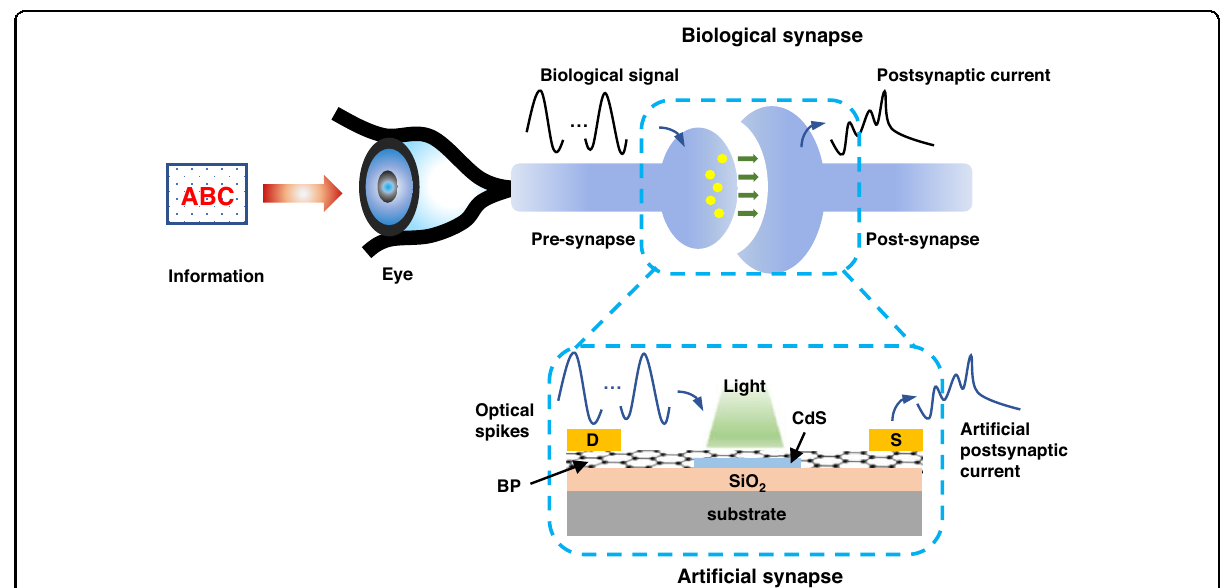
Fig. 1 Schematic view of biological synapse and designed arti fi cial synaptic